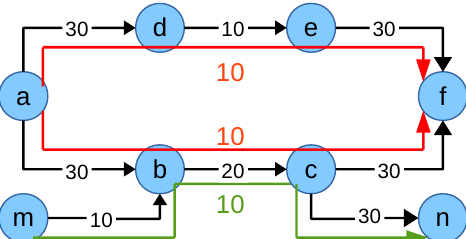
Figure 4. Example for network flow fair allocation. Blue circles: nodes; black arrows/numbers: links with capacities. Colored arrows/numbers: flows with capacity assignments. All numerical values in